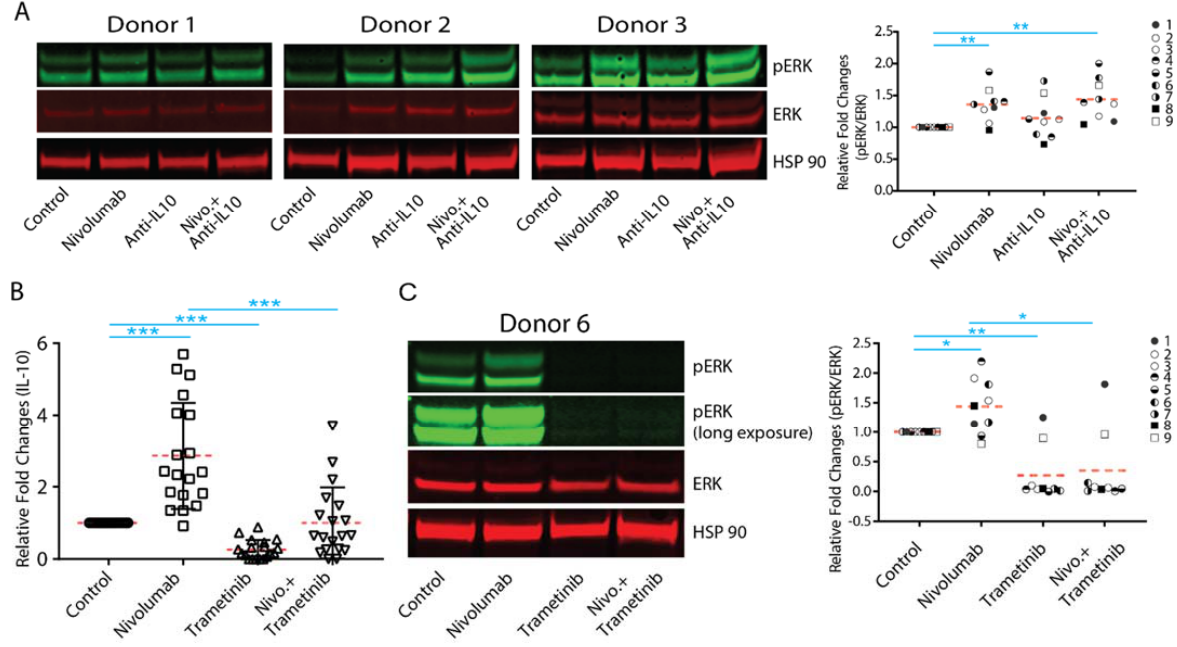
Figure 6. Nivolumab ‐ mediated upregulation of interleukin ‐ 10 (IL ‐ 10) production depends on the activation of the mitogen ‐ activated protein kinase (MAPK) pathway. ( A , B , C ) Purified T cells were co ‐ cultured with allogeneic monocyte ‐ derived dendritic cells in the presence of nivolumab (20 μ g/mL) with or without anti ‐ IL ‐ 10 mAb (5 μ g/mL) for 5 days. ( A ) Cells were harvested for WB analyses for the MAPK signaling pathway. Shown are three donor pairs representative of 9 donor pairs. HSP90 and total ERK were used as loading controls (left panel). Quantitation of the Western blot results (combined with donor 4 to 9 is presented in Figure S5) was conducted using ImageJ software. The activation of the ERK pathway is determined by the band intensity of pERK divided by the band intensity of total ERK (right panel). Student’s t test, ** p < 0.01. ( B ) Purified T cells were co ‐ cultured with allogeneic monocyte ‐ derived dendritic cells in the presence of nivolumab (20 μ g/mL) with or without trametinib (0.2 μ g/mL) for 5 days. Cell culture media were harvested for Luminex analyses of IL ‐ 10 production ( n = 19). ( C ) Purified T cells were co ‐ cultured with allogeneic monocyte ‐ derived dendritic cells in the presence of nivolumab (20 μ g/mL) with or without trametinib (0.2 μ g/mL) for 5 days. Cells were harvested for WB analyses for the MAPK signaling pathway. Shown is a Western Blot of one donor pair representative of nine donor pairs (left panel). Quantitation of the Western blot results (combined with donor 2 to 9 is presented in Figure S6) was conducted using ImageJ software. The activation of the ERK pathway is determined by the band intensity of pERK divided by the band intensity of total ERK (right panel). Student’s t ‐ test, * p < 0.05, ** p < 0.01,*** p < 0.001.